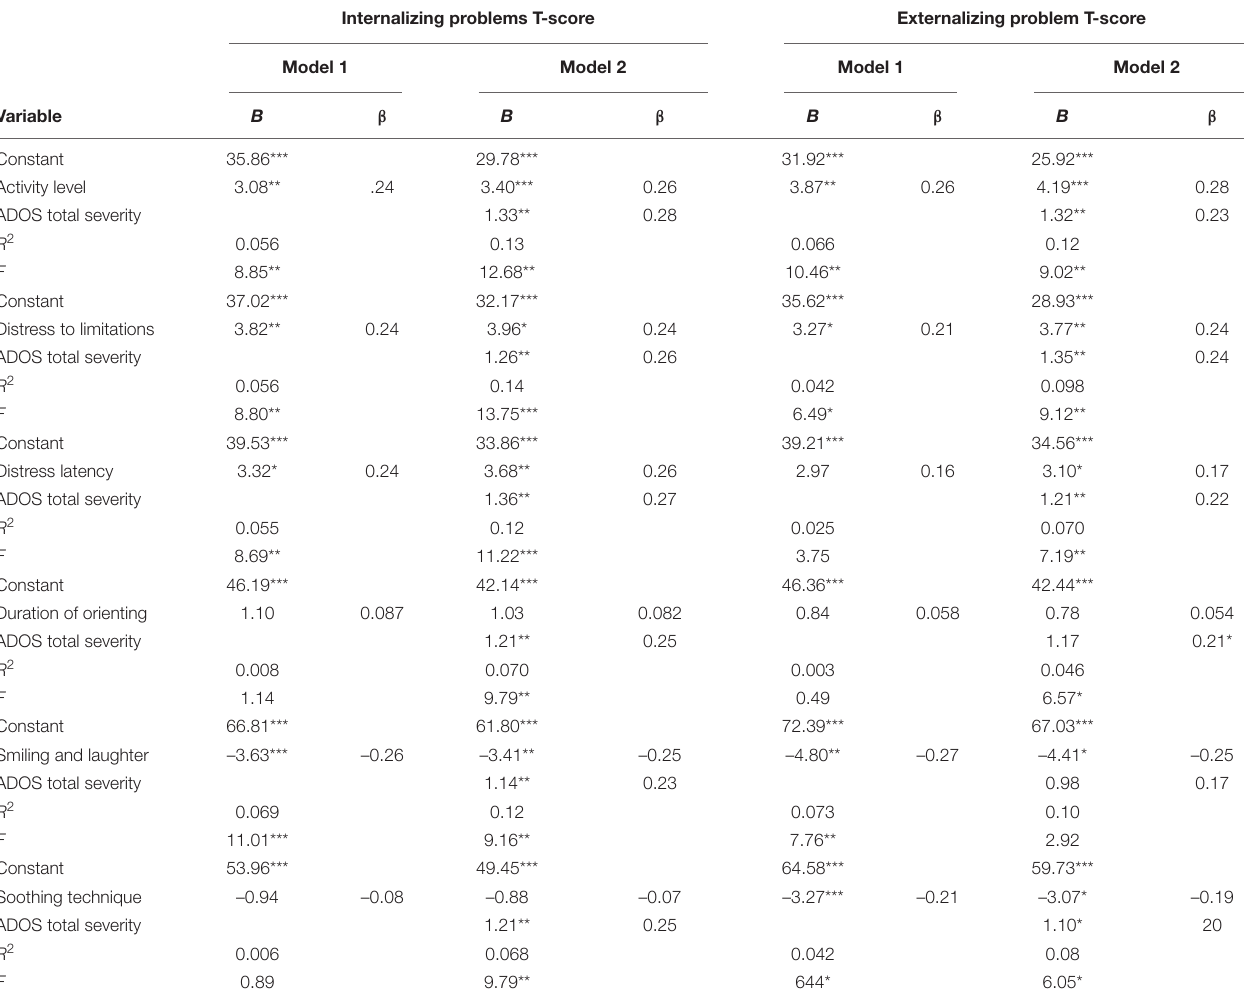
TABLE 4 | Predictive relationships between 5-year internalizing and externalizing problems and 12 months temperament scales. Internalizing problems